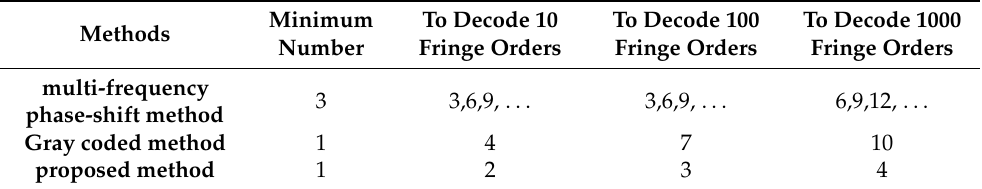
Table 2. The comparison result of the number of additional coded patterns required in addition to sinusoidal fringe patterns when phase unwrapping is performed using the multifrequency phase-shift method, gray coded method, and the proposed